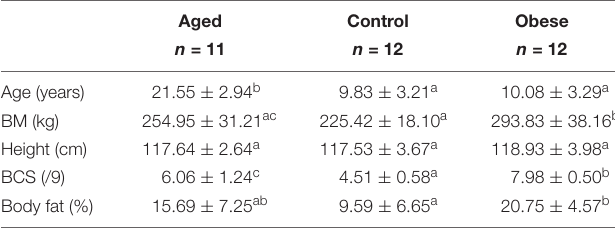
TABLE 1 | Outset phenotype data (mean ± SD) for animals in the current study.